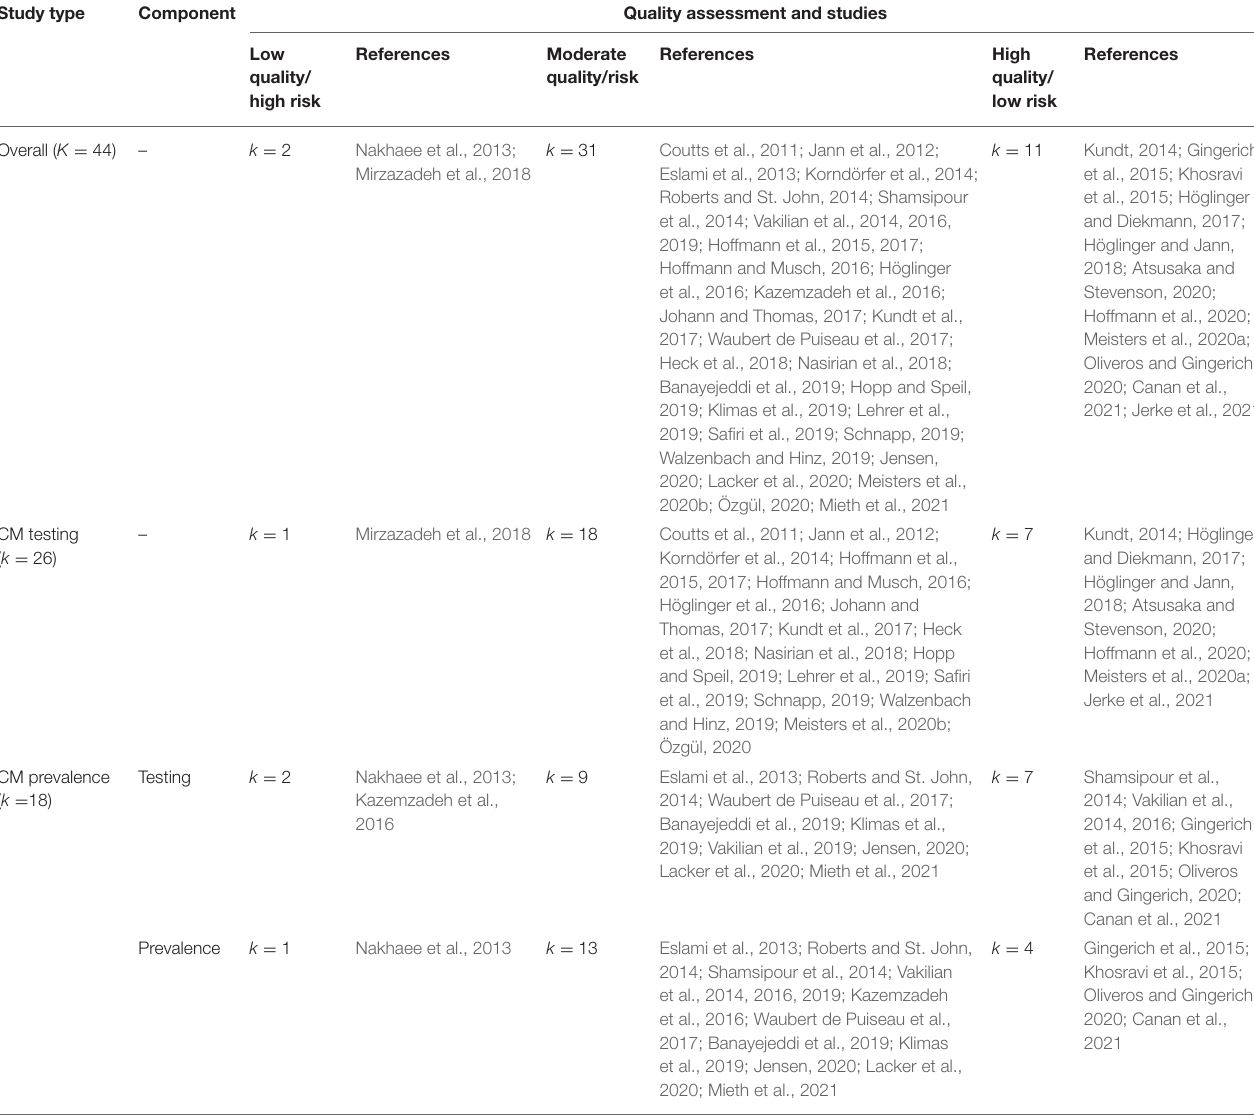
Excluded from analysis/table: Jerke et al. (2019)—qualitative